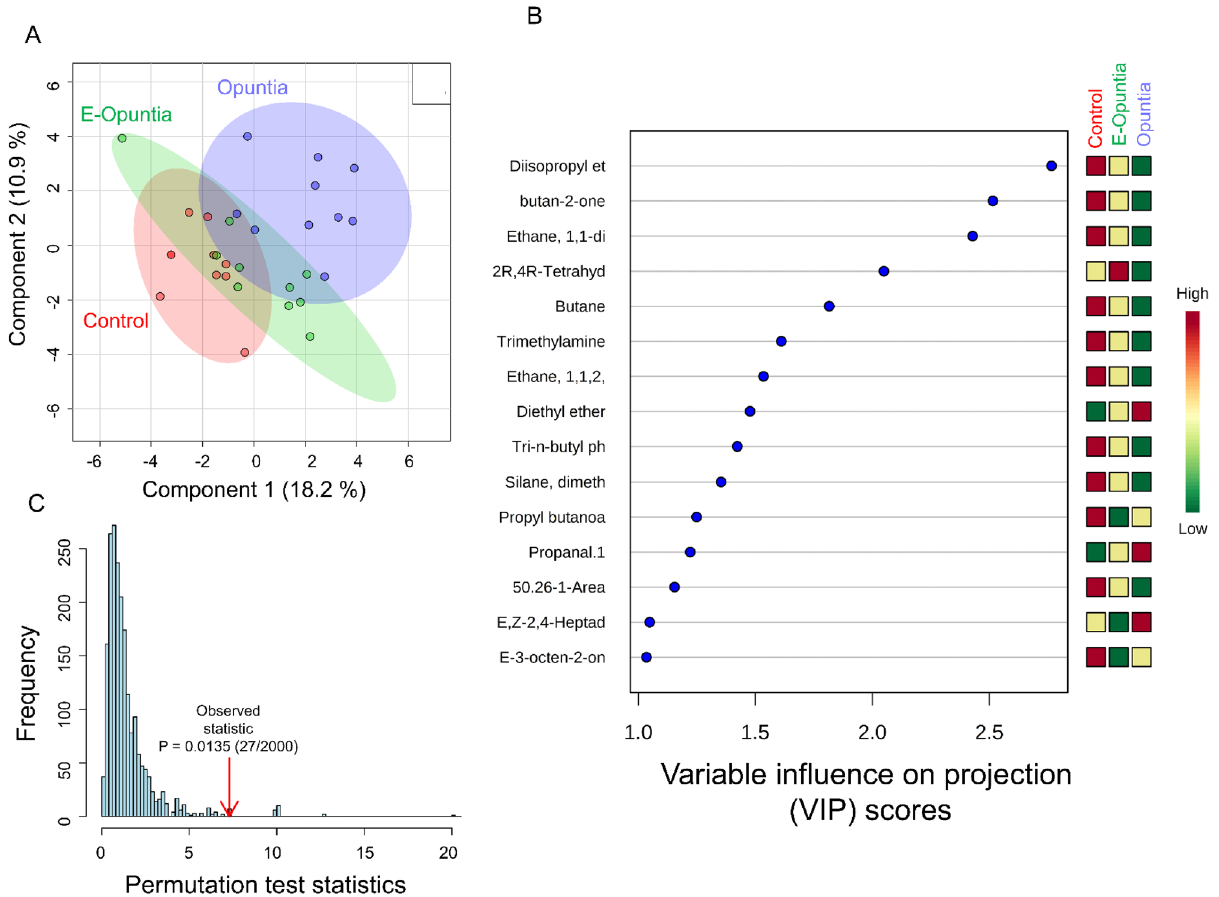
Figure 1. ( A ) Partial least squares-discriminant analysis (PLS-DA) showing 2 clusters for 3 treatments (Control, E-Opuntia, Opuntia); ( B ) the metabolites ranked by variable importance in projection (VIP) before the start of dietary treatments (Day 0). ( C ) PLS-DA model validation by permutation tests based on separation distance of treatments. The p-value based on permutation was P = 0.014 (27/2000). Metabolomics data analysis was performed using the free web-based metabolomics tool (MetaboAnalyst 4.0; https:// www. metab oanal yst. ca/ home. xhtml) 54